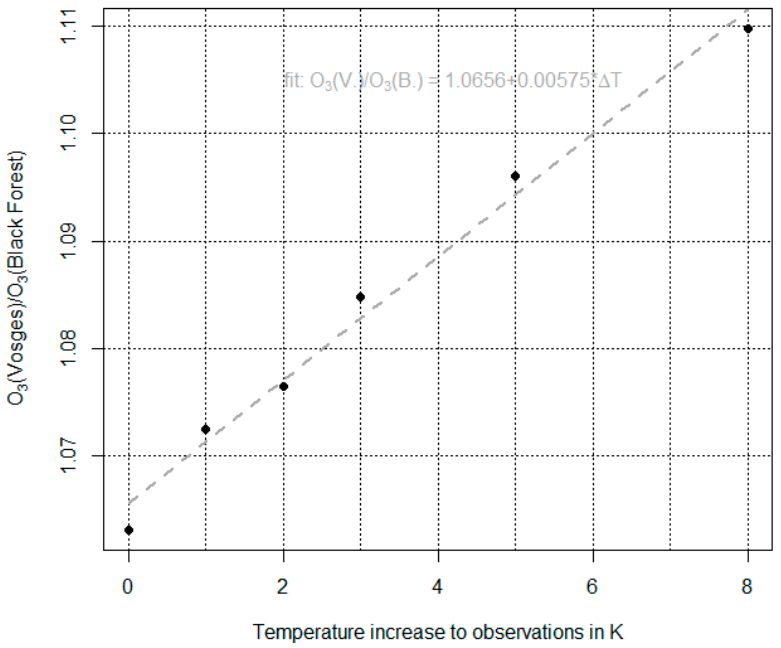
Figure 8. Effect of temperature on calculated ozone differences for different forest